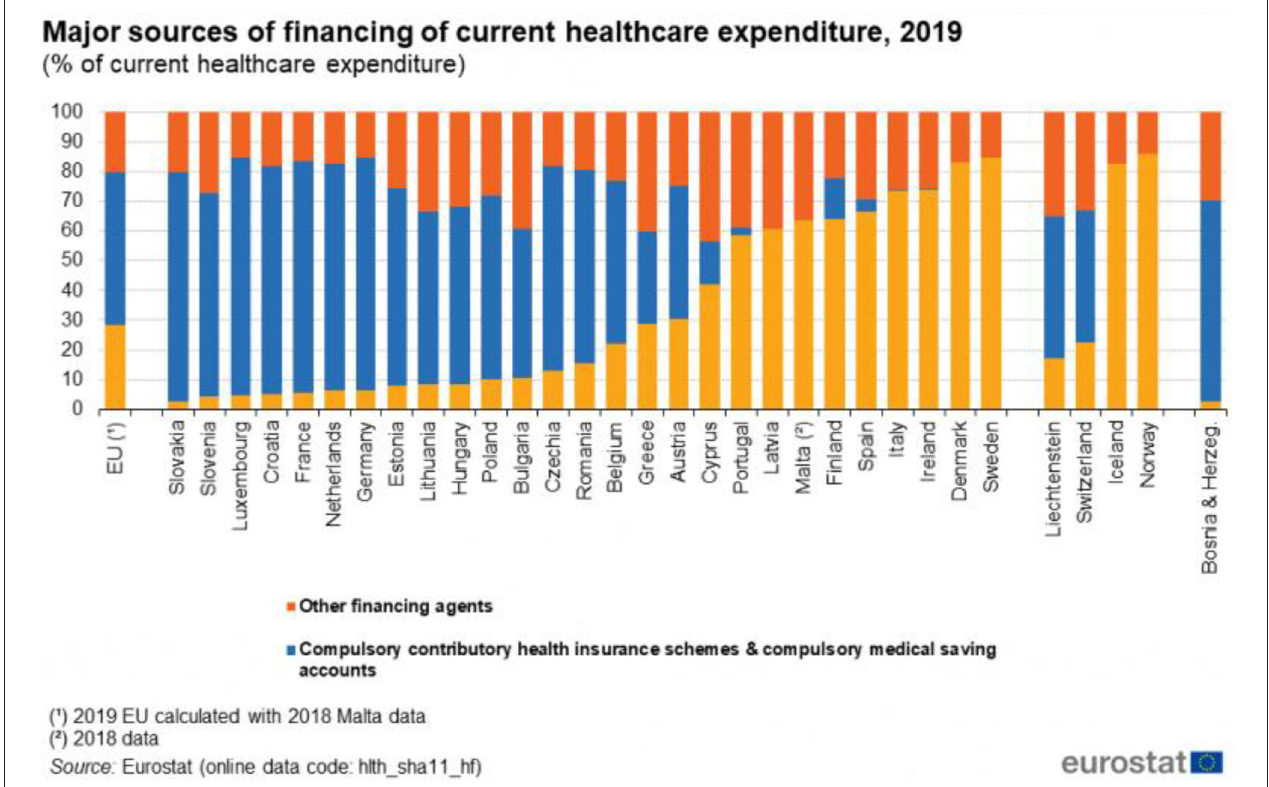
FIGURE 11 | Major sources of financing of current healthcare expenditure in EU countries, 2019 (%) (32). Source: Eurostat https://ec.europa.eu/eurostat/statistics- explained/index.php?title=Healthcare_expenditure_statistics, accessed